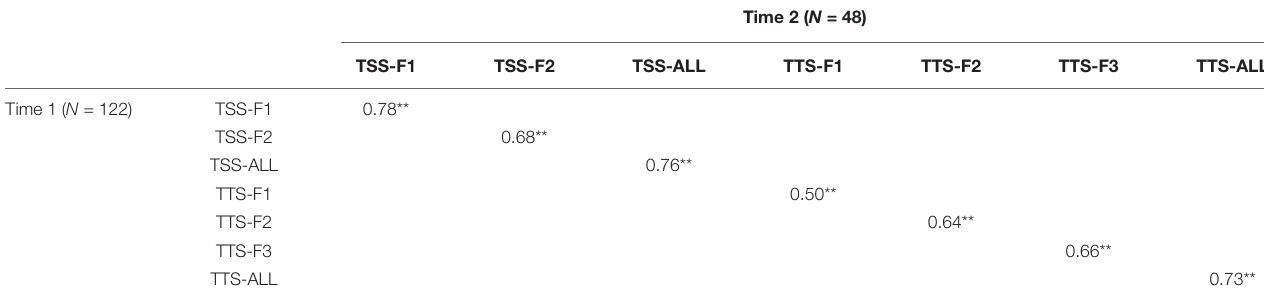
TABLE 13 | Pearson correlation coefficients for the test–retest reliability between the two time